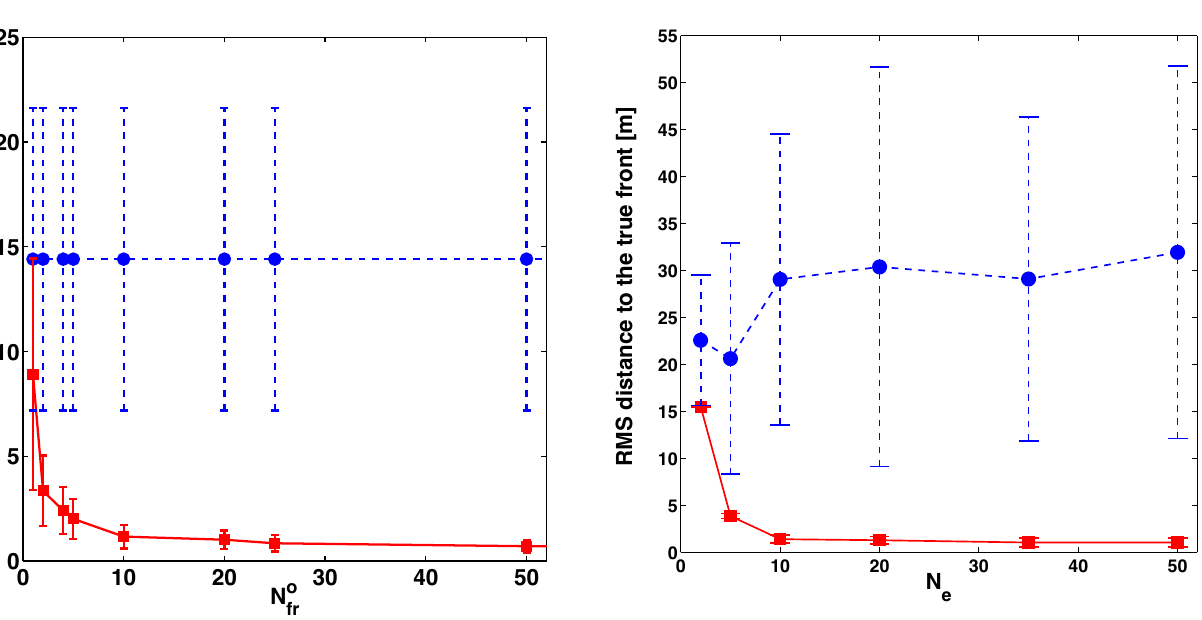
Figure 8. Average distance between the true and forecast fire front positions (blue circles) and between the true and analysis fire front positions (red squares) at time 150s as a function of the number of members N e in the ensemble; OSSE anisotropic case. Error bars indicate the associated